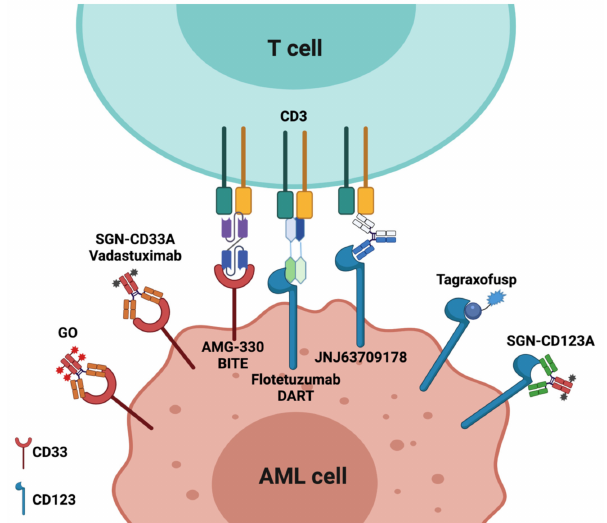
Figure 1. Immunotargeting of validated targets in AML: approved versus investigational molecules. CD33 targeting: GO (Gentuzumabozogamicin) for favorable and intermediate AML in association with daunorubicine and cytarabine; SGN-CD33A and AMG-330 under investigation. CD123 targeting: tagraxofusp approved; SGN-123A, flotetuzumab, and JNJ63709178 investigational. The figure was created with